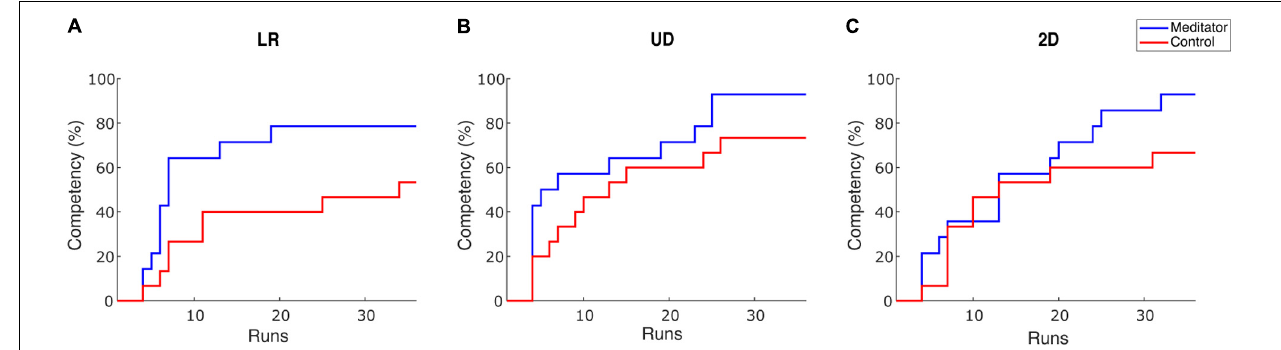
FIGURE 3 | Competency curves for (A) LR, (B) UD and (C) 2D tasks. Competency describes the percentage of subjects passing the performance threshold (70% for 1D and 40% for 2D). Each session has 6 runs for one task, accounting for 36 runs in total throughout the 6 training sessions.